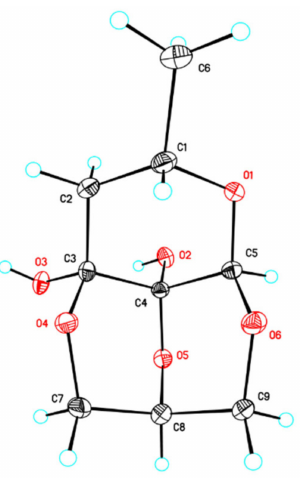
Figure 3. Ortep diagram of 5